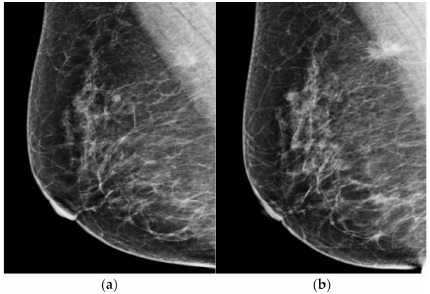
Figure 3. Representative dismissed case by AI-CAD. A 62-year-old woman classified as negative in a mammography screening ( a ). When looking at the mammography in retrospect, asymmetry